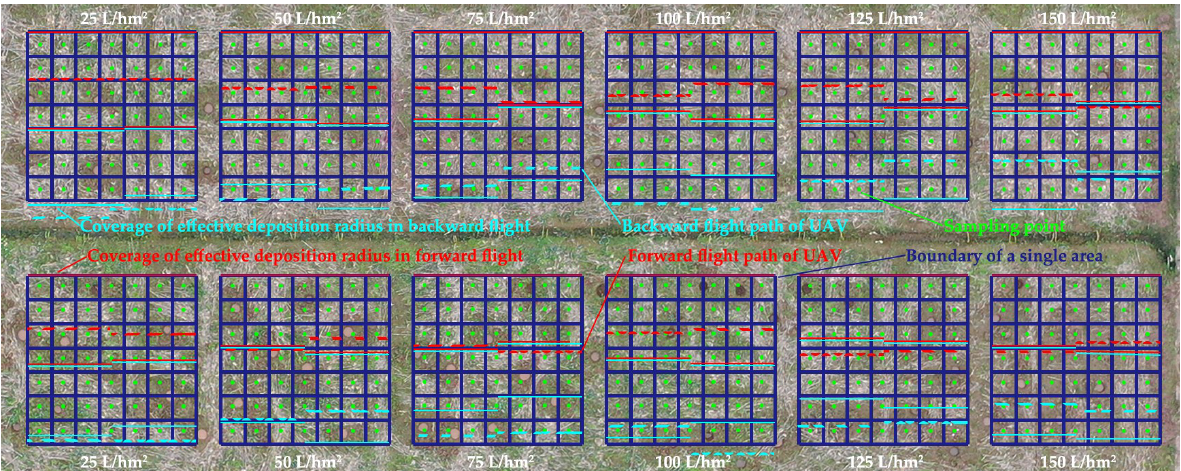
Figure 16. Diagrammatic sketch of flight path and effective deposition radius coverage. The UAV takes off from the upper-right corner of Figure 16 and moves to the left, which is a forward flight. After reaching the left boundary of the site, the UAV flies from left to right again, which is a backward flight. The flight height is set to 2 m, and the flight velocity is set to 0.5 m/s. The droplet diameter depends on the nozzle pressure in Figure